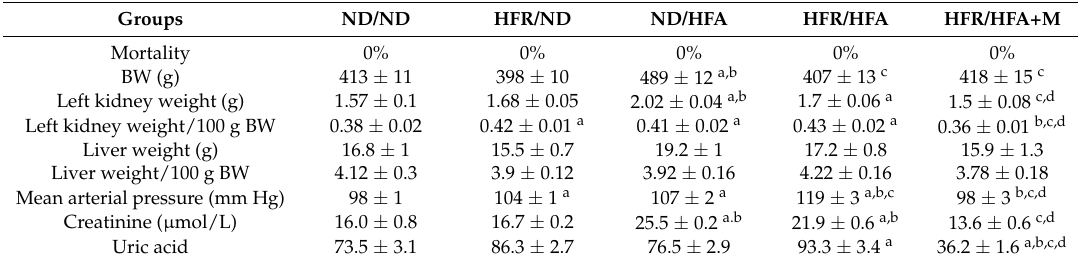
Table 1. Measures of body and organ weights, blood pressures, and functional parameters in 12-week-old male offspring exposed to maternal high fructose intake, post-weaning high-fat diet, and metformin.